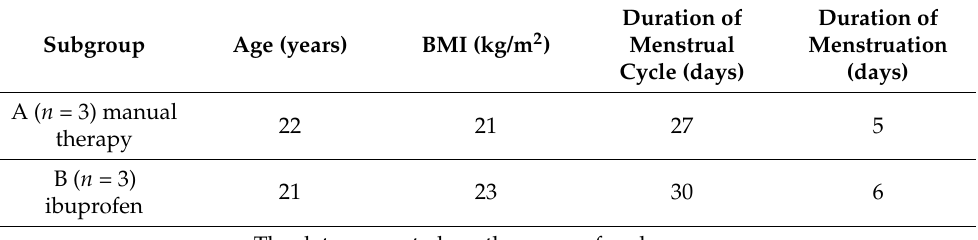
Table 1. Characteristics of patients with dysmenorrhea in subgroup A and